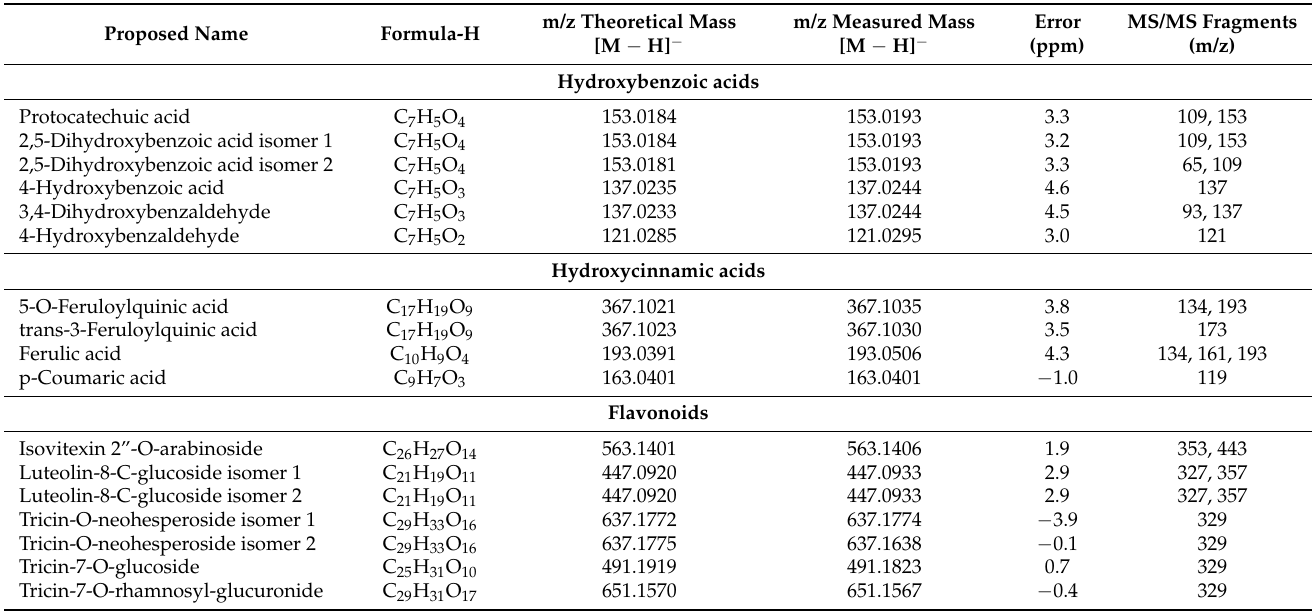
Table 2. LC-ESI-UHR-QqTOF-MS data of phenolic compounds identified in straw extract af- ter saccharification.